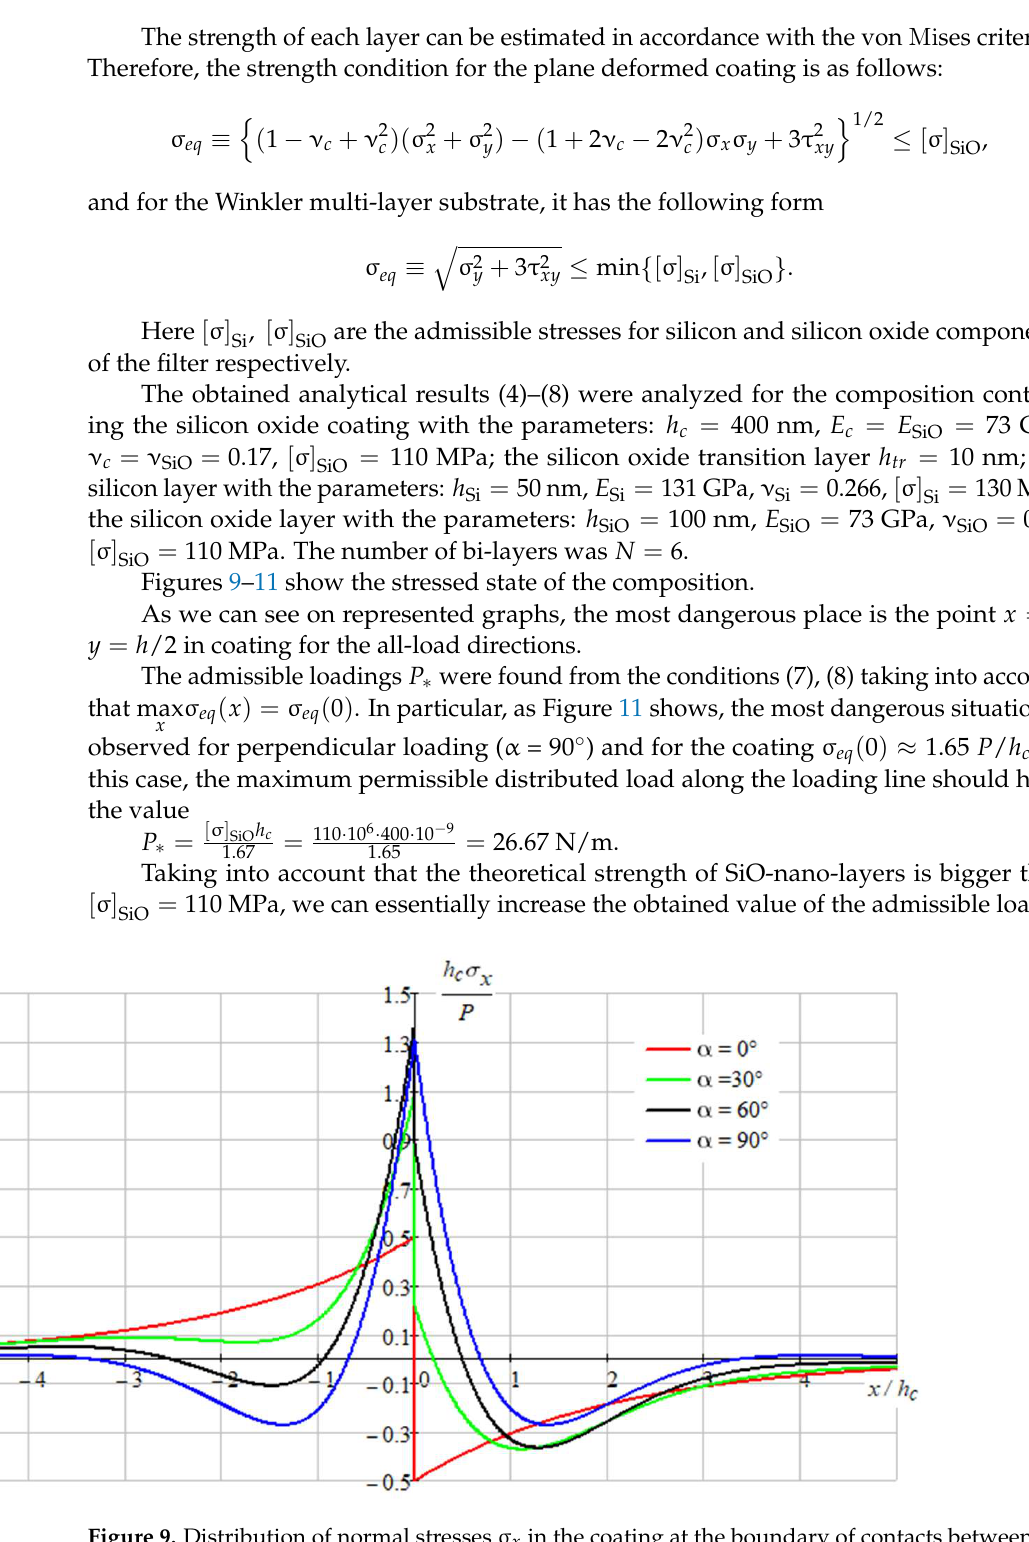
( a ) ( b ) Figure 10. Distribution of stresses: ( a ) — y  ; and ( b ) — xy  in the filter layers.